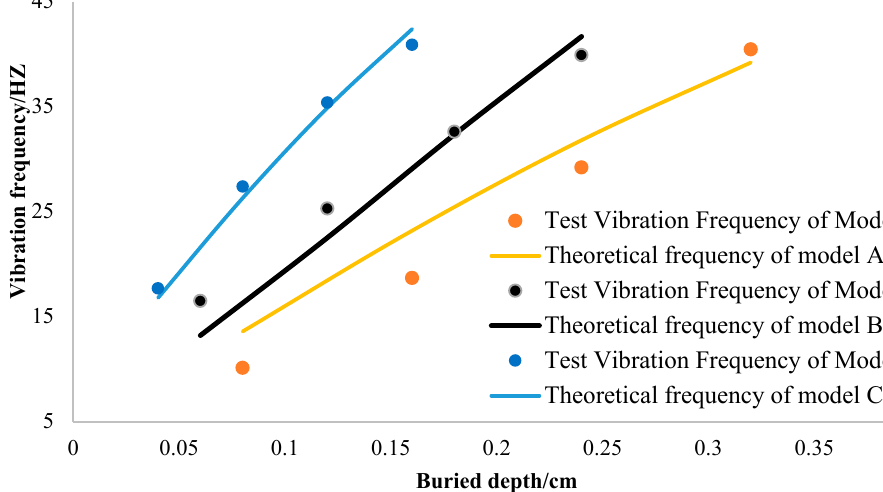
Figure 7. Relationship between natural vibration frequency and buried depth.